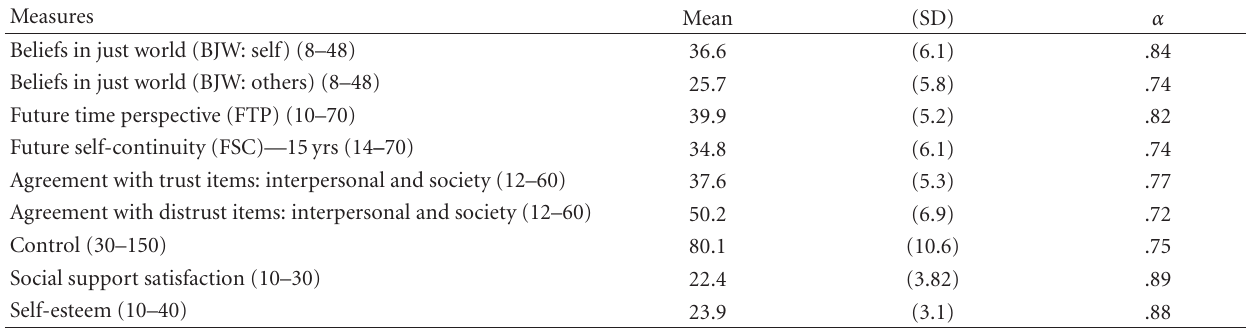
Table 2: Psychometric information on beliefs in just world (self and others) and other related future time perspective measures and trust